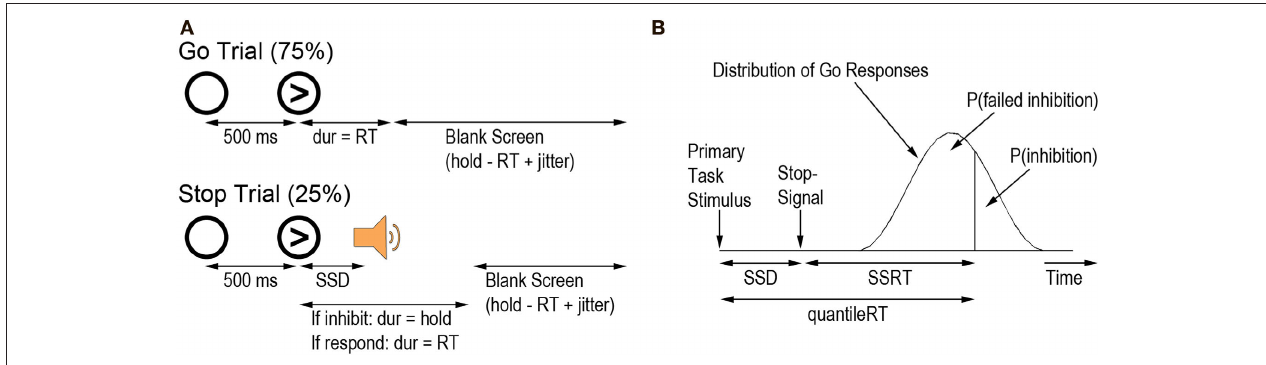
FIguRe 1 | (A) Schematic of go trials and stop trials. (B) The race model of stopping (Logan and Cowan, 1984). All correct RTs were arranged in ascending order in an assumption-free distribution to calculate the RT at each participant’s proportion of failed inhibition (quantileRT). SSRT could then be calculated as quantileRT – SSD. Figure adapted from Aron et al.